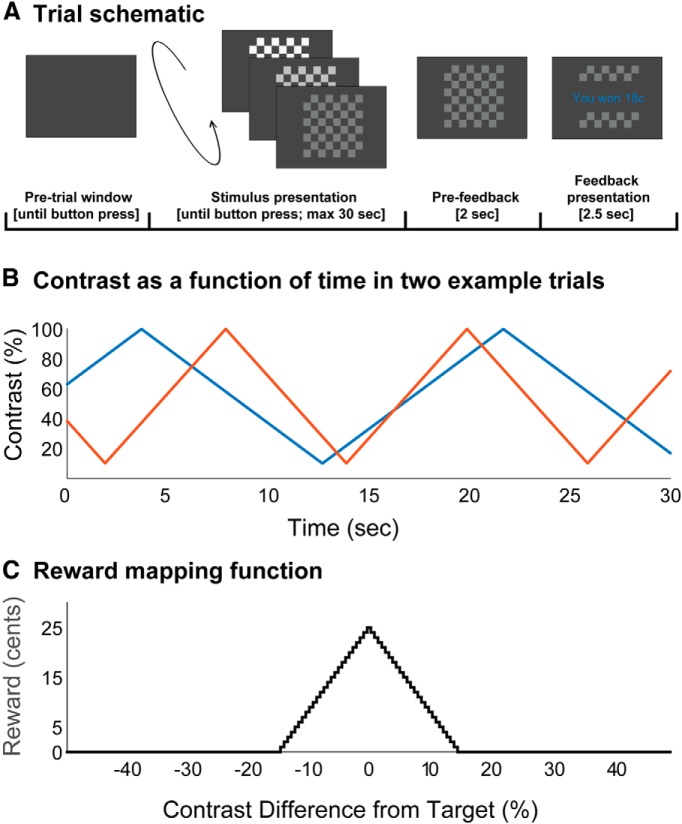
A, Following a self-paced button press, a checkerboard stimulus was presented whose contrast changed linearly. The participant could at any time select the contrast displayed on screen by pressing a button with the right index finger. The trial continued until a button was pressed or until stimulus duration exceeded 30 s. Following the participant’s choice, the selected contrast remained on screen for 2 s, after which time the monetary reward associated with the chosen contrast was displayed for 2.5 s. In the event that no button was pressed within 30 s, feedback was a message reminding the participant of the task instructions. B, Two demonstrative examples of stimulus contrast as a function of elapsed time. Example trial 1 (blue) has an initial contrast of 63%, is initially increasing, and has a half-cycle period of 9 s. Example trial 2 (red) has an initial contrast of 39%, is initially decreasing, and has a half-cycle period of 6 s. The checkerboard stimulus phase reversed at a rate of 12 Hz. C, Functional mapping between the contrast difference from target and monetary reward. The mapping was a symmetrical triangular function with a center of 0% contrast difference, a half-width of 15% contrast difference, and a height of 25 cents. As such, the received reward was maximal when the participant responded at the target contrast and decreased linearly with increasing difference of chosen contrast from the target. The reward was 0 for responses at >15% distance. Feedback received was rounded to the nearest whole-cent value.